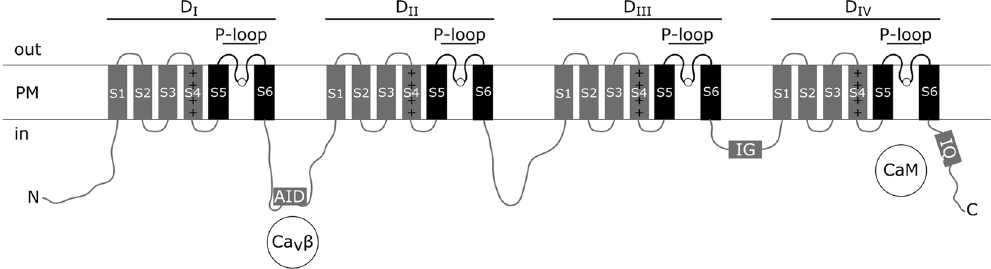
Figure 1. Schematic representation of the four-domain voltage-gated cation channel structure. Functional determinants considered in this work are shown. The pore-forming subunit consists of four homologous domains (D I –D IV ). Each domain comprises six transmembrane segments (S1–S6). Segments S4 may bear positive charges ( + ) and function as a voltage sensor. Segments S5 and S6 together with a pore-loop (P-loop) form a pore of a channel. Four amino acid residues, one from each P-loop (white circles), form a selectivity filter. AID – α -interaction domain; CaM – calmodulin; Ca v β – auxiliary β -subunit of HVA Ca v ; IG – Na v -type inactivation gates; IQ – calmodulin-binding region containing pre-IQ and IQ motifs; PM – plasma